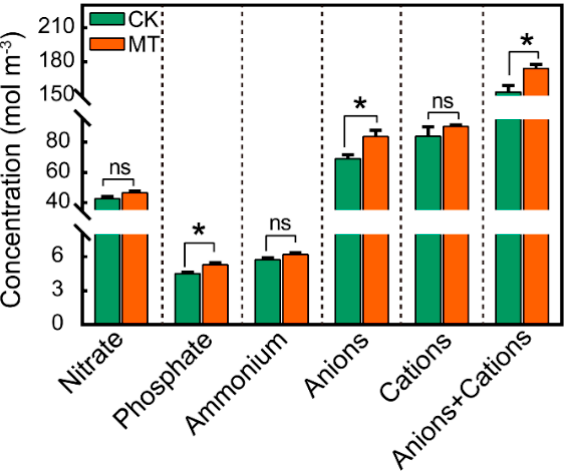
Figure 3. The concentration of nitrate, phosphate, ammonium, anions, cations, and anions and cations in leaves of Phragmites australis under control (CK) and melatonin (MT). “ns” indicates not significant and “*” indicates significance at p < 0.05. Data are expressed as means ± SE (n = 3).